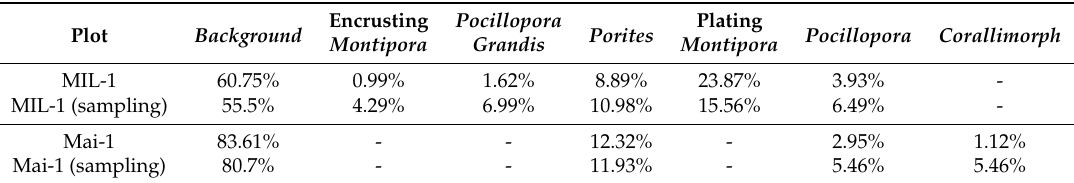
Table 5. Class frequencies on training area before and after the application of our over-sampling strategy. The training area selection comes from the ecologically inspired partition. Encrusting Pocillopora Plating Porites Pocillopora Plot Background